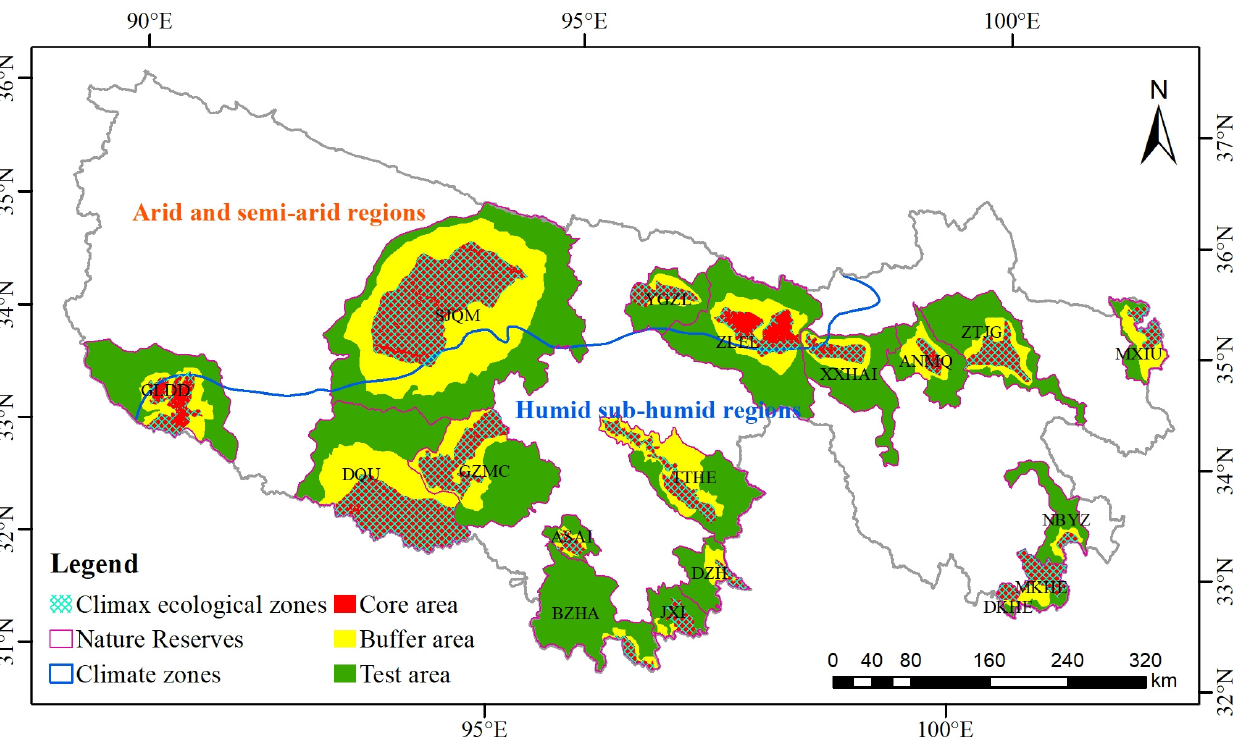
Figure 3. Distribution of TRHR climax ecological zones (not including water bodies in the core area), climate zones, and nature reserves (core area, buffer area, test area).